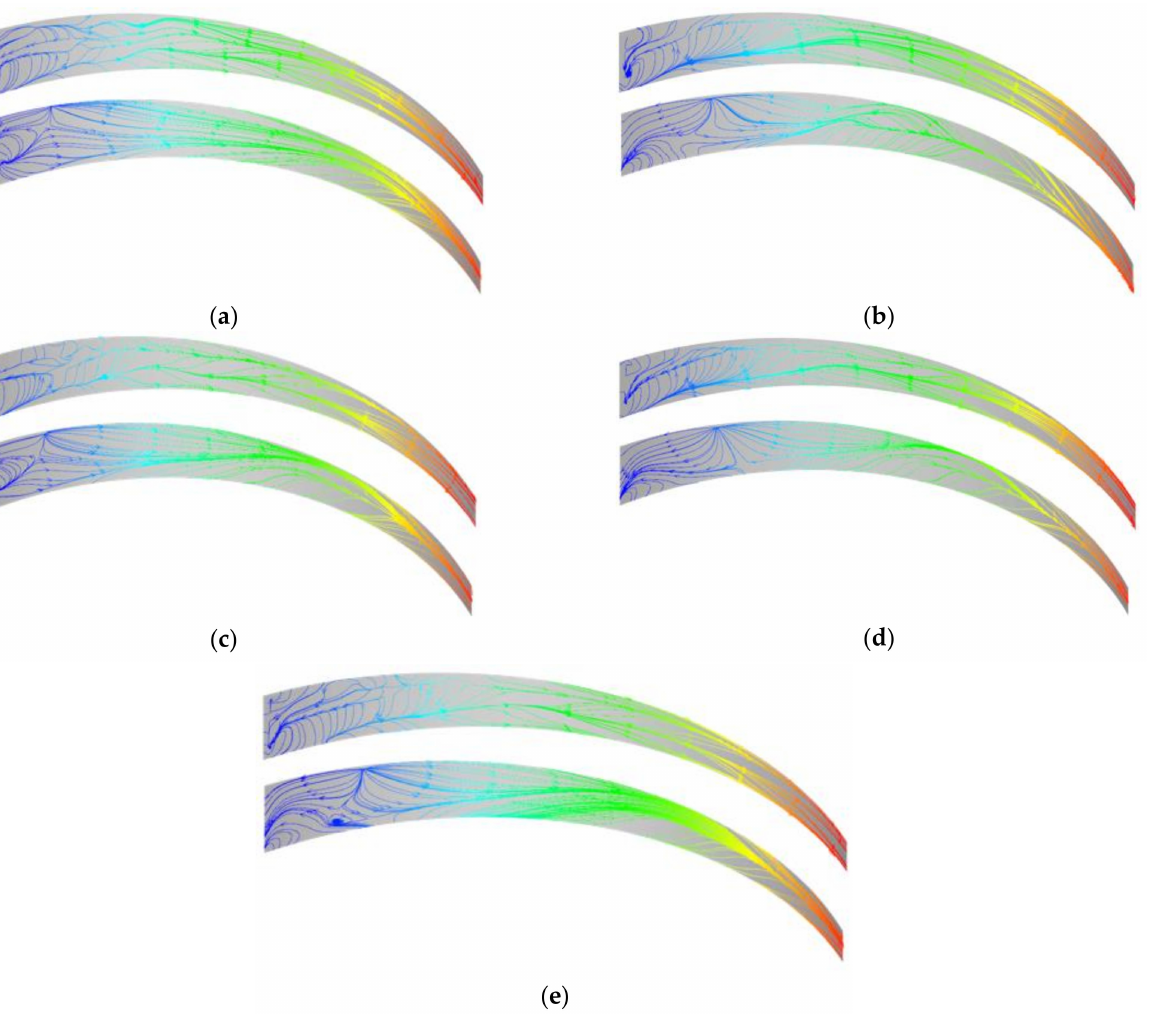
Figure 12. Instantaneous limiting streamlines on the pressure ( top ) and suction ( bottom ) surfaces of the blade for (from ( a – e )) U rot /U ref = − 0.5, 0.5, − 0.3, 0.3 and